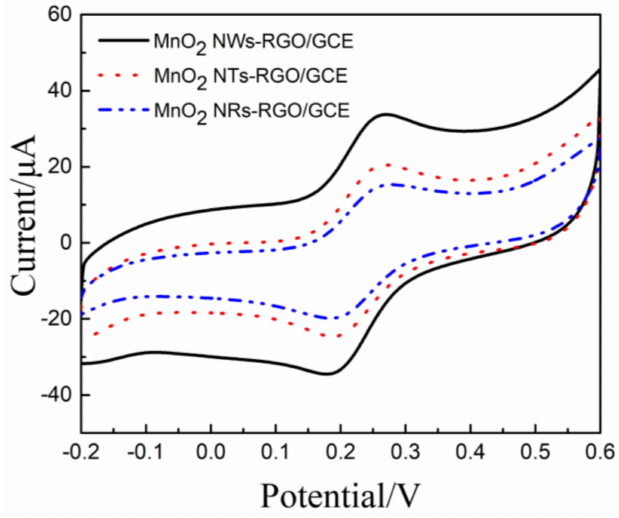
Figure 3. Cyclic voltammograms of MnO 2 NWs-RGO/ glass carbon electrode (GCE), MnO 2 NRs-RGO/GCE, and MnO 2 NTs-RGO/GCE in 1.0 × 10 − 3 mol/L [Fe(CN) 6 ] 3 − /4 − probe solution (scan rate: 0.05 V · s − 1 ; supporting electrolytes: 0.1 mol/L pH 3.0